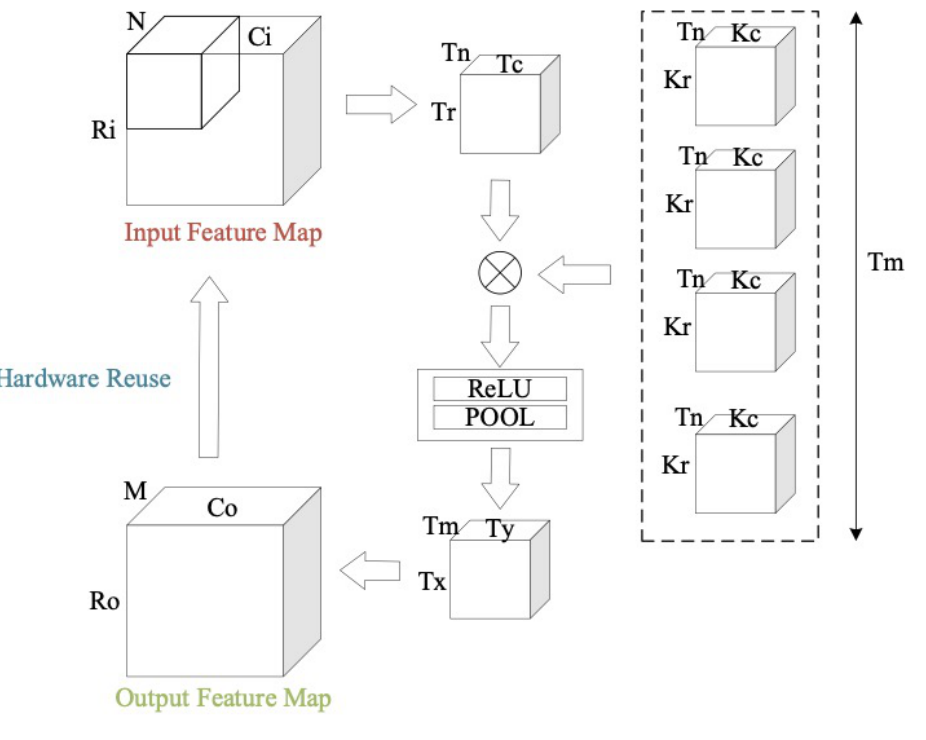
Figure 3. Implementation diagram of CNN.